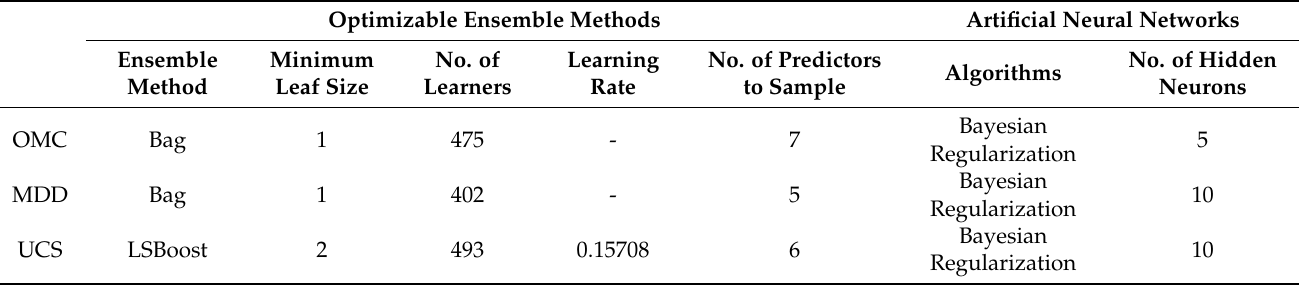
Table 4. Optimized hyperparameters that yielded the optimal results.